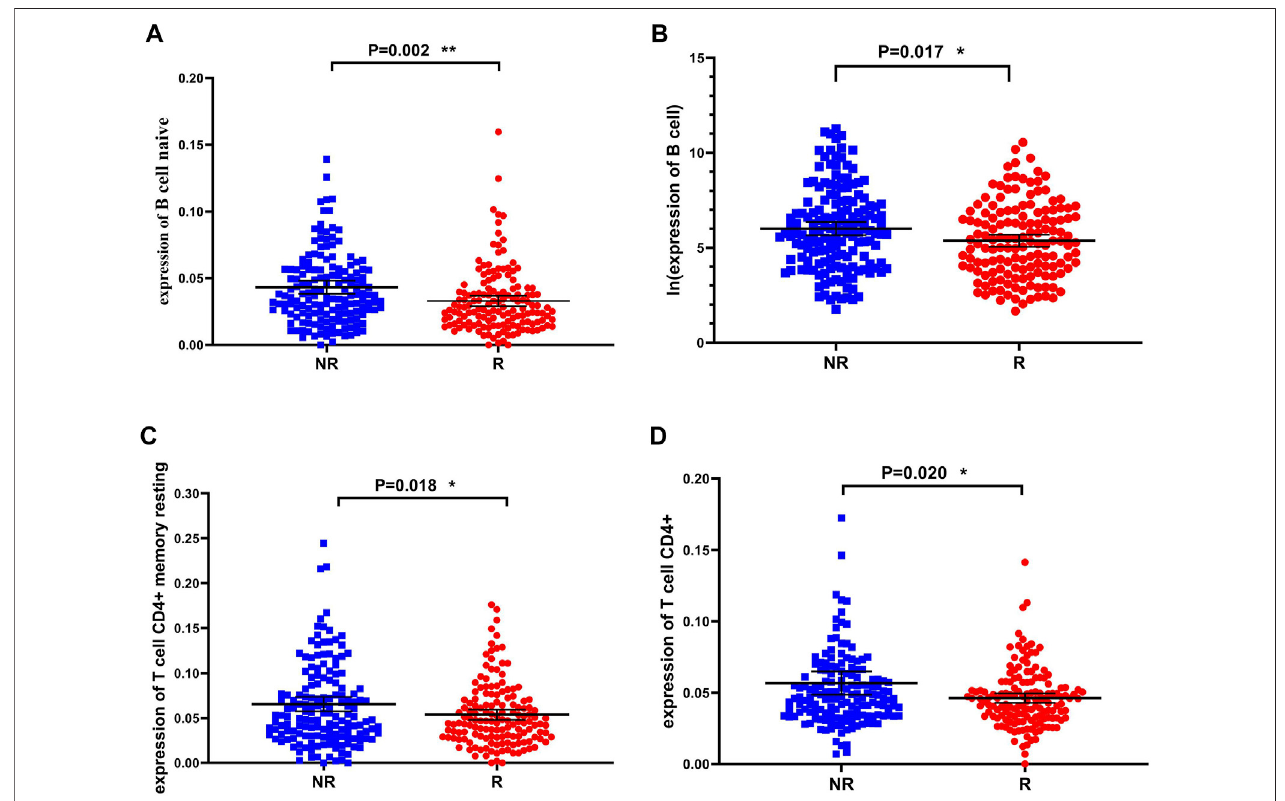
FIGURE3| Immunecellsthataresigni fi cantlydifferentbetweentherecurrenceandnon-recurrencegroups (A) Bcellnaiveexpressionbetweenthetwogroups (B) B cellexpression betweenthe twogroups (C) TcellCD4 + memoryrestingexpression betweenthe twogroups (D) TcellCD4 + expression between thetwogroups.* p < 0.05, ** p < 0.01 and *** p <